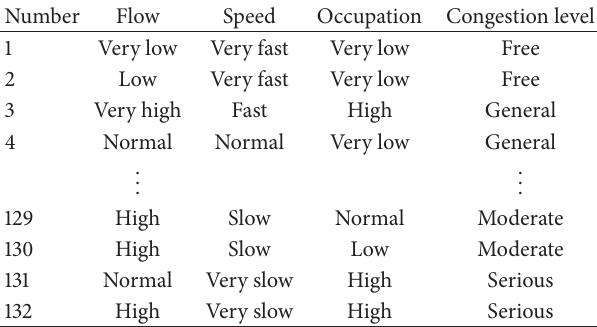
Table 7: Identification results of traffic flow